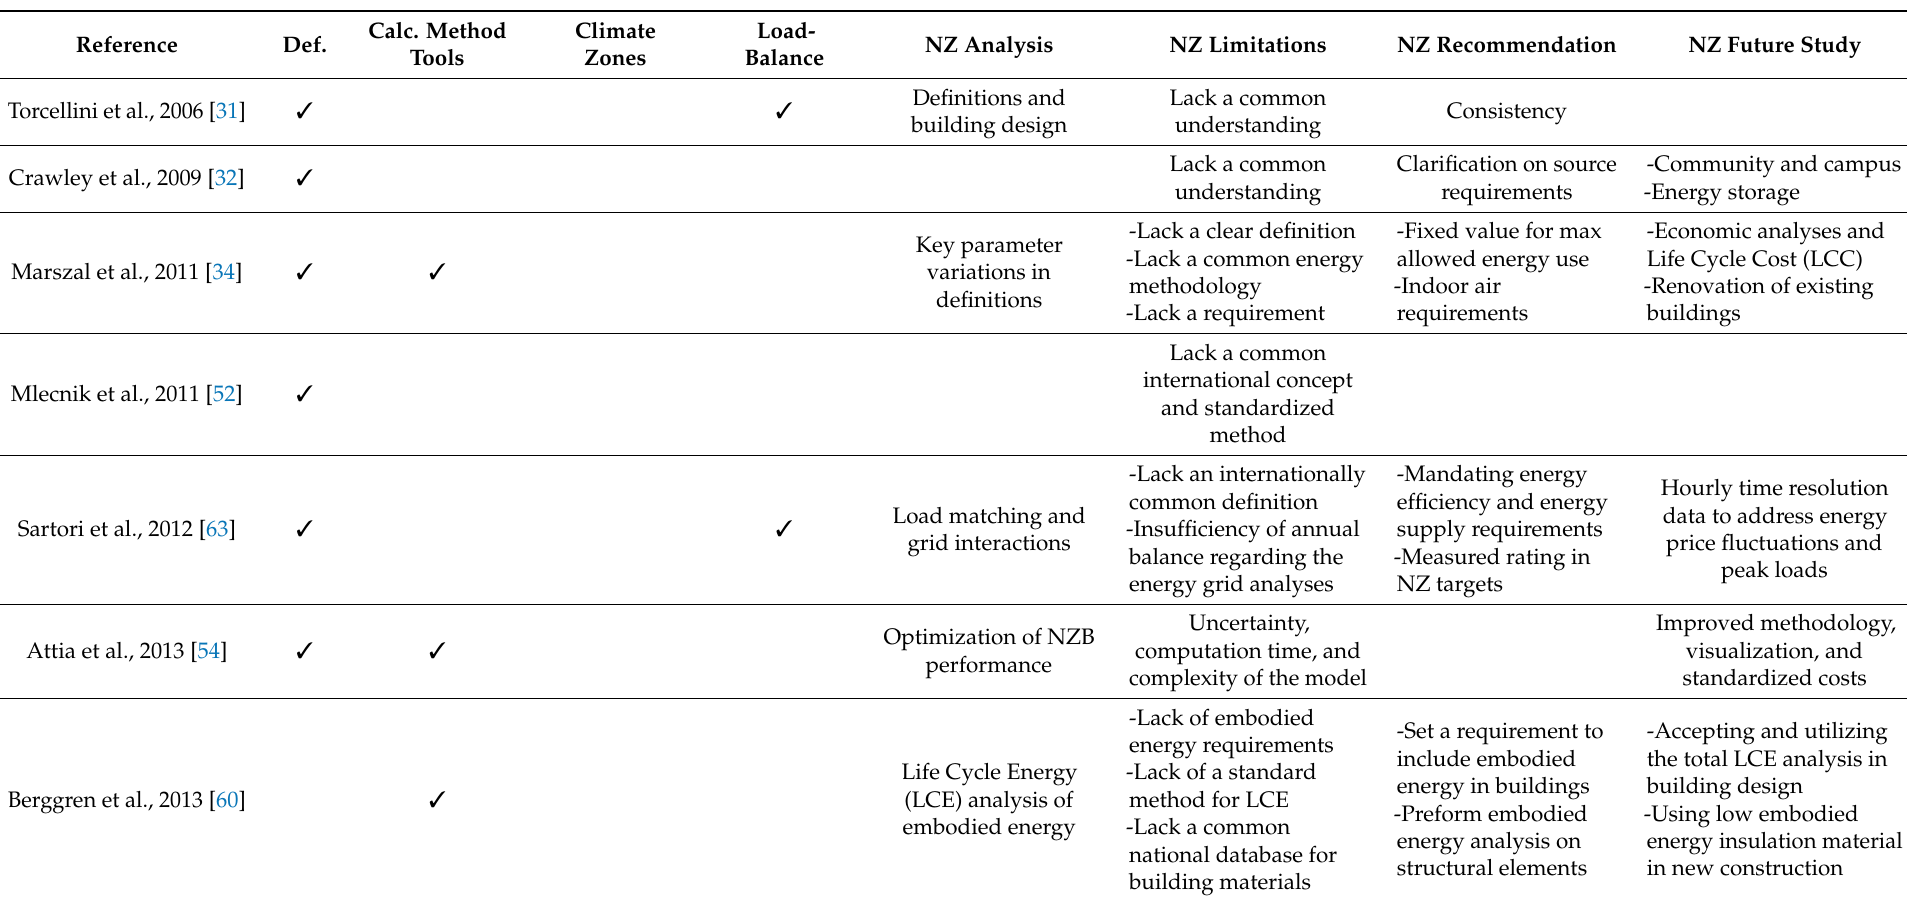
Table 3. A comprehensive literature list on NZ variations and